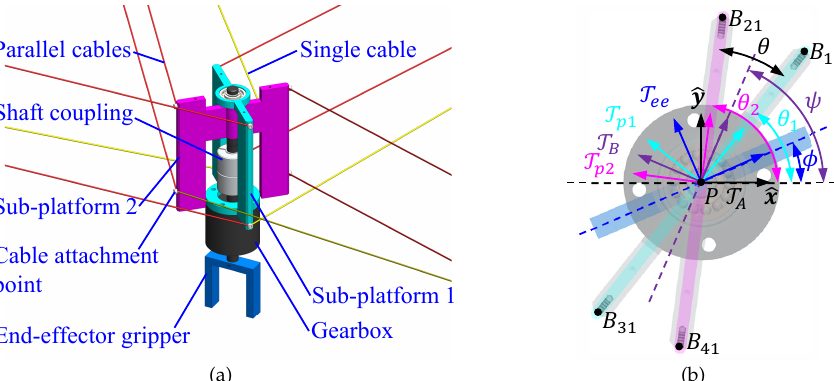
Figure 4. Architecture of the articulated moving platform. ( a ) Front view. ( b ) Top